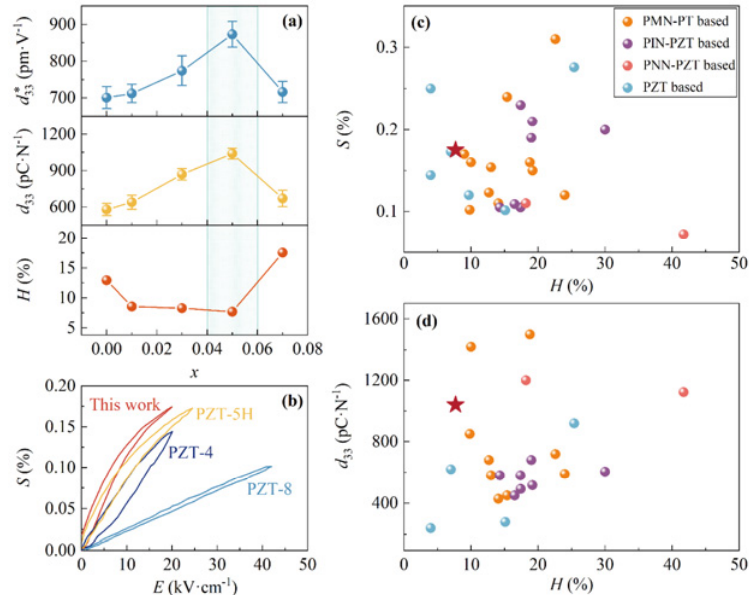
Fig. 6 (a) Composition dependence